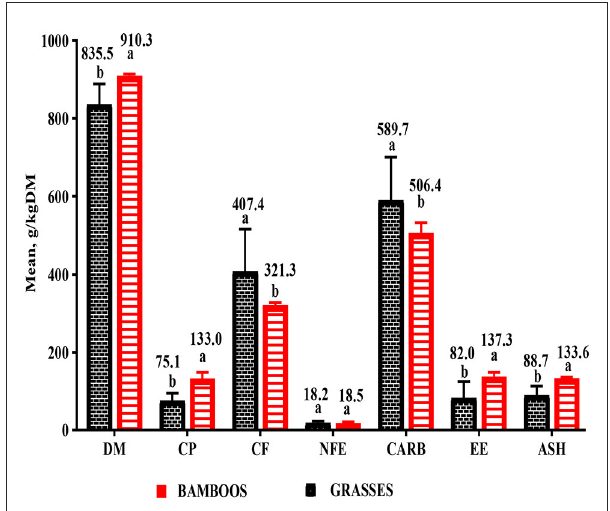
FIGURE1 Average proximate and fiber pools for bamboo ( Bambusa balcooa (Beema), Oxytenanthera abyssinica (A. Rich.) Munro and Bambusa vulgaris) and grass ( Cenchrus purpureus, Megathyrsus maximus, and Brachiaria decumbens ) leaf biomasses. Data points are mean of means ( n = 3) ± SEM. Data bars with similar superscripts (a, b ) are not significantly different (p > 0.05); DM, dry matter; CP, crude protein; CF, crude fiber; EE, ether extract: NFE, nitrogen-free extract; CARB, carbohydrate.